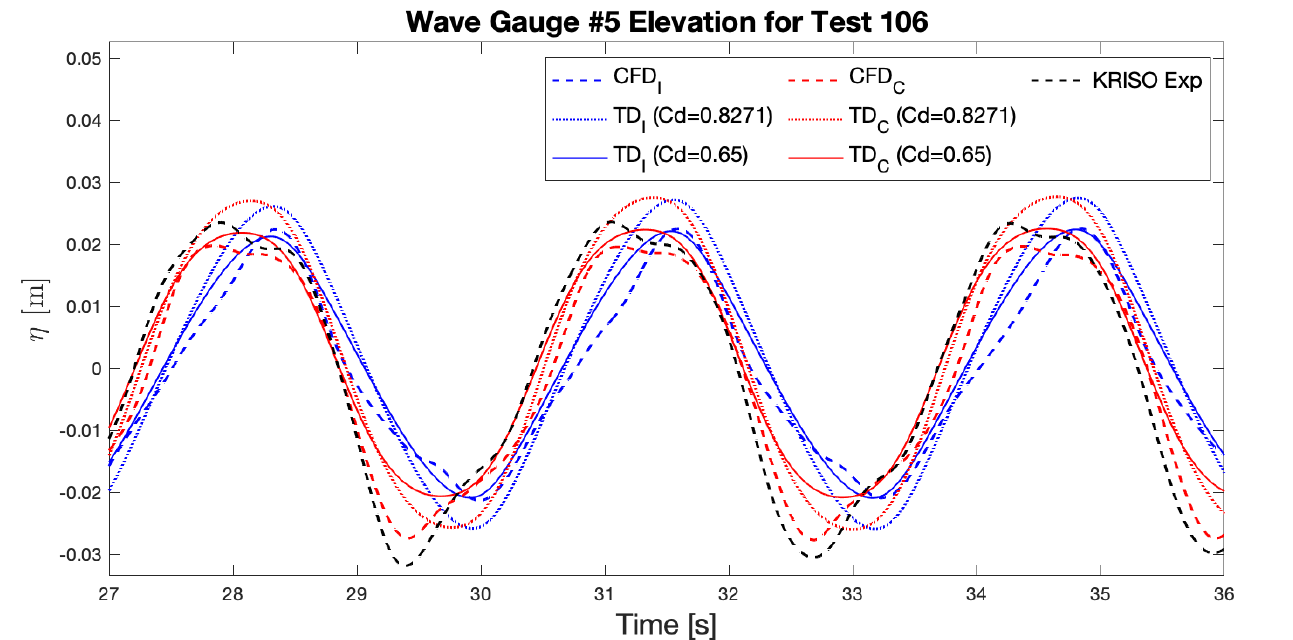
Figure 27. The measured, CFD simulated, and potential flow method predicted surface elevation at the center of the chamber for Test